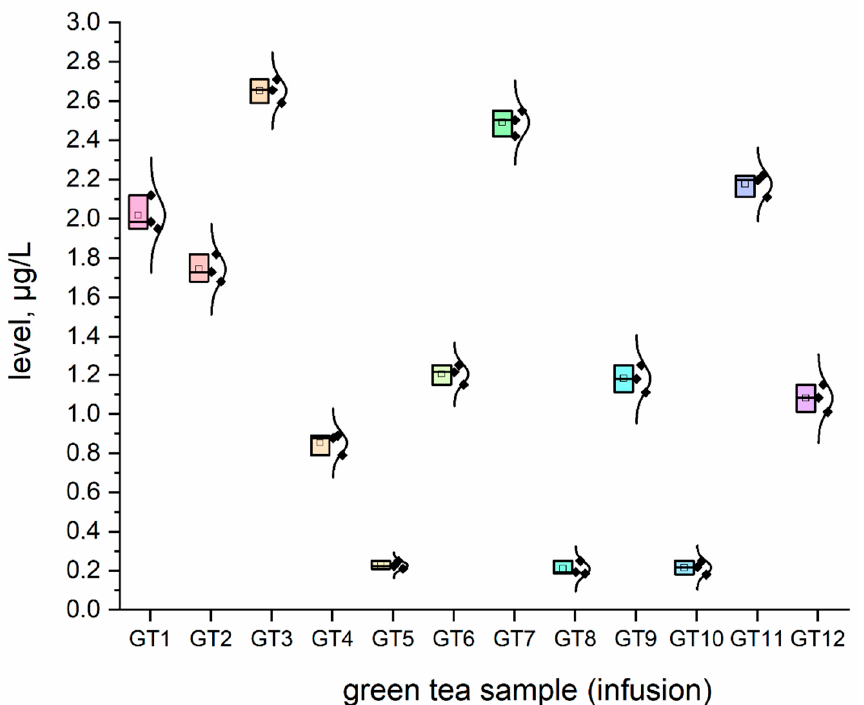
Figure 4. The plot as a box chart with, a normal distribution curve for Li concentration ( μ g/L) in analysed green tea samples (infusions; GT1–GT12). The colors indicate the results for the individual tested samples, the symbol indicates the standard deviation.